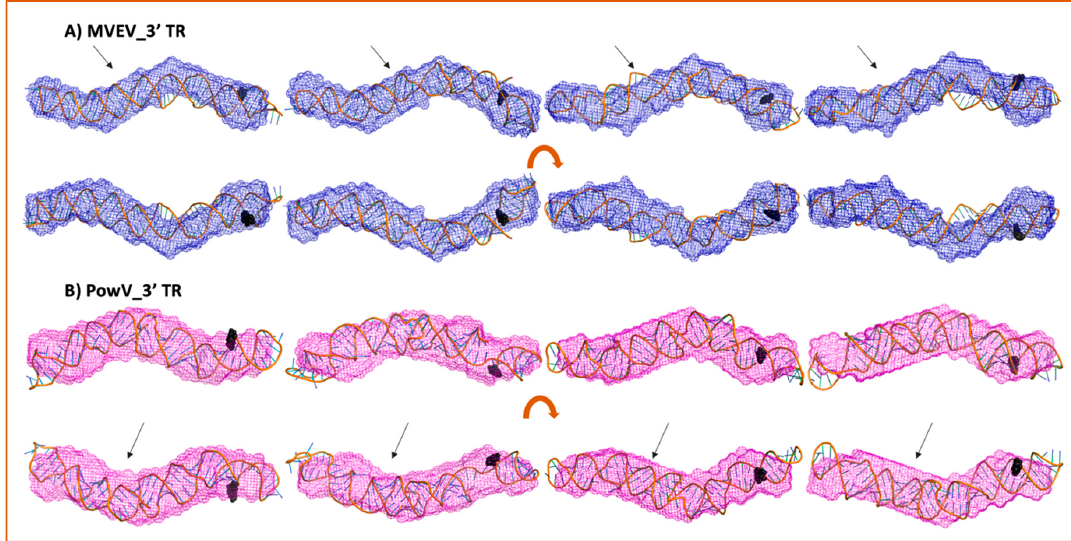
Figure 7. High-resolution structures calculated using MC-SYM overlaid with low-resolution SAXS models. A) MVEV 3TR and B) PowV 3TR. Bottom panels in both cases represent an 180 o rotation along the x-axis represented in the top panels. Black spheres represent 5’ terminal region on each construct. The arrows represent stem-loop I (SLI) location in 3’ TRs.